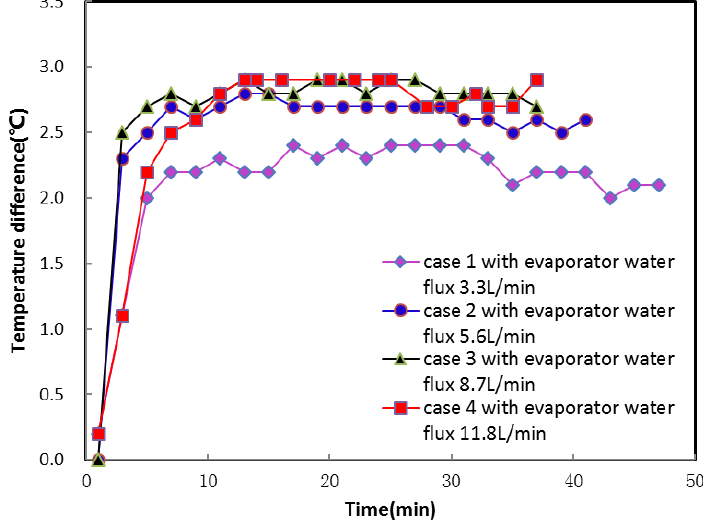
Figure 8. Condenser inlet and outlet water temperature differences at different evaporator water fluxes.